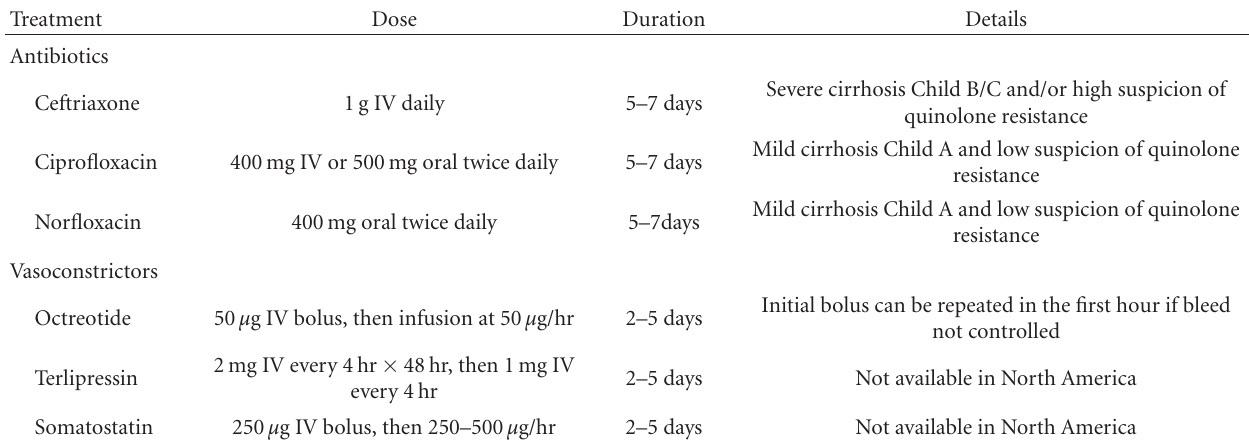
Table 2: Initial medical management of acute variceal